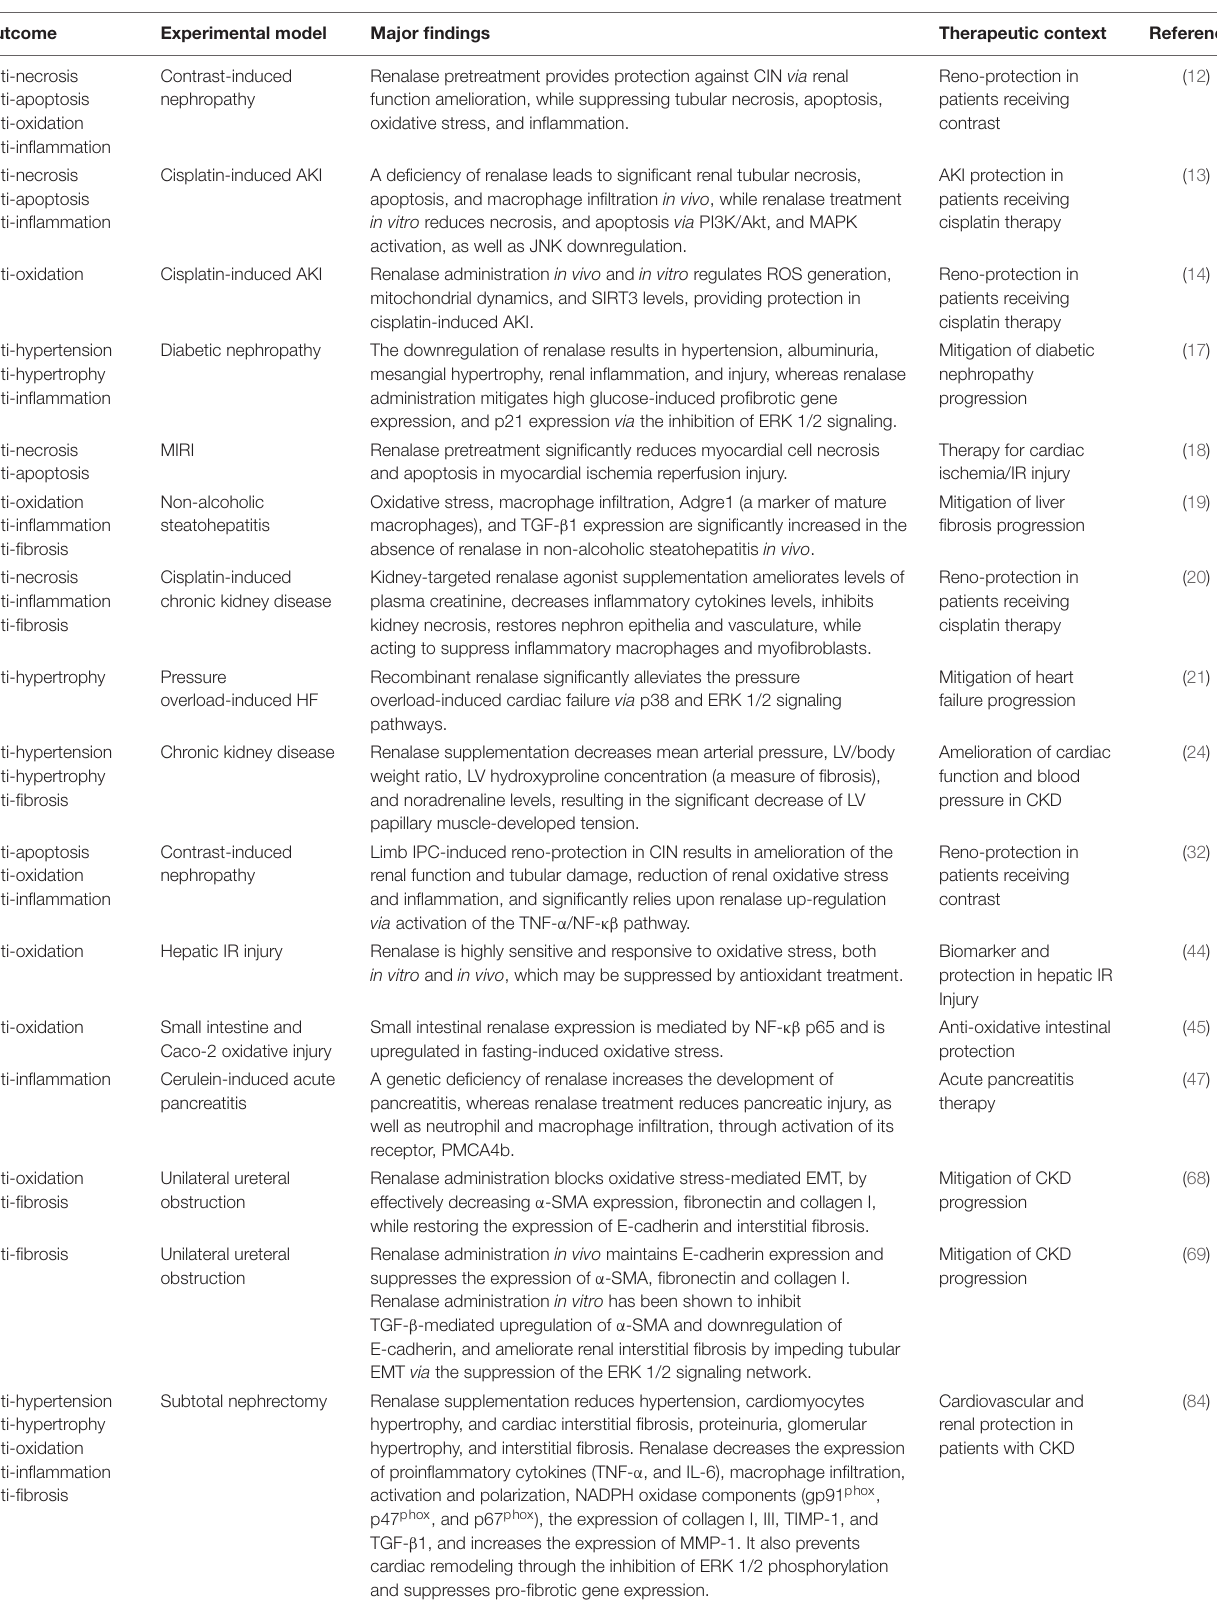
TABLE 1 | A summary of the effects of renalase based upon current experimental